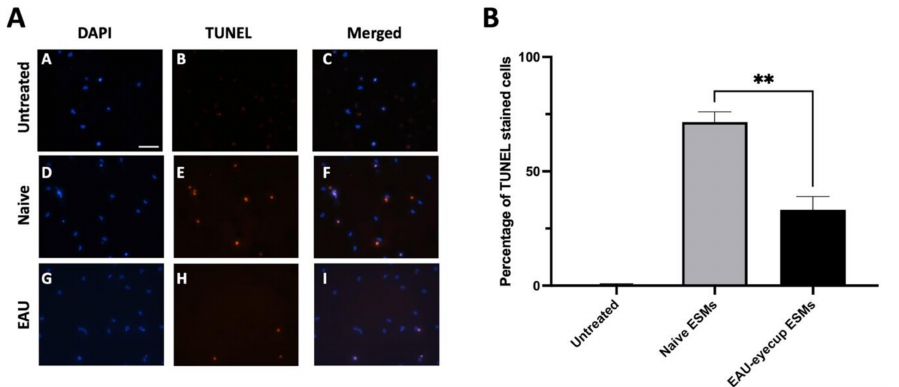
Figure 4. RPE ESMs induction of apoptosis in primary macrophages. The peritoneal macrophages from naive mice were treated with the ESMs from the conditioned media of naive RPE eyecups (Naive) or EAU RPE eyecups (EAU) or were untreated (Media). ( A ) The cultures were incubated for 24 h and stained by TUNEL assay. No TUNEL-positive cells were observed in the untreated cultures (micrographs A–C); TUNEL-positive cells were seen in the cultures of macrophages treated with ESMs from naive and EAU RPEs (micrographs D–I). Scale bar = 50 µ m. ( B ) The cells from the TUNEL assay were counted, and the percentage of TUNEL-positive cells is presented as the mean ± SEM. The macrophages treated with naive ESMs had a significantly (** p ≤ 0.01) higher percentage of TUNEL-positive cells (72 ± 4%) than macrophages treated with EAU ESMs (33 ± 6%). The ESMs isolated from RPE eyecups induce apoptosis in